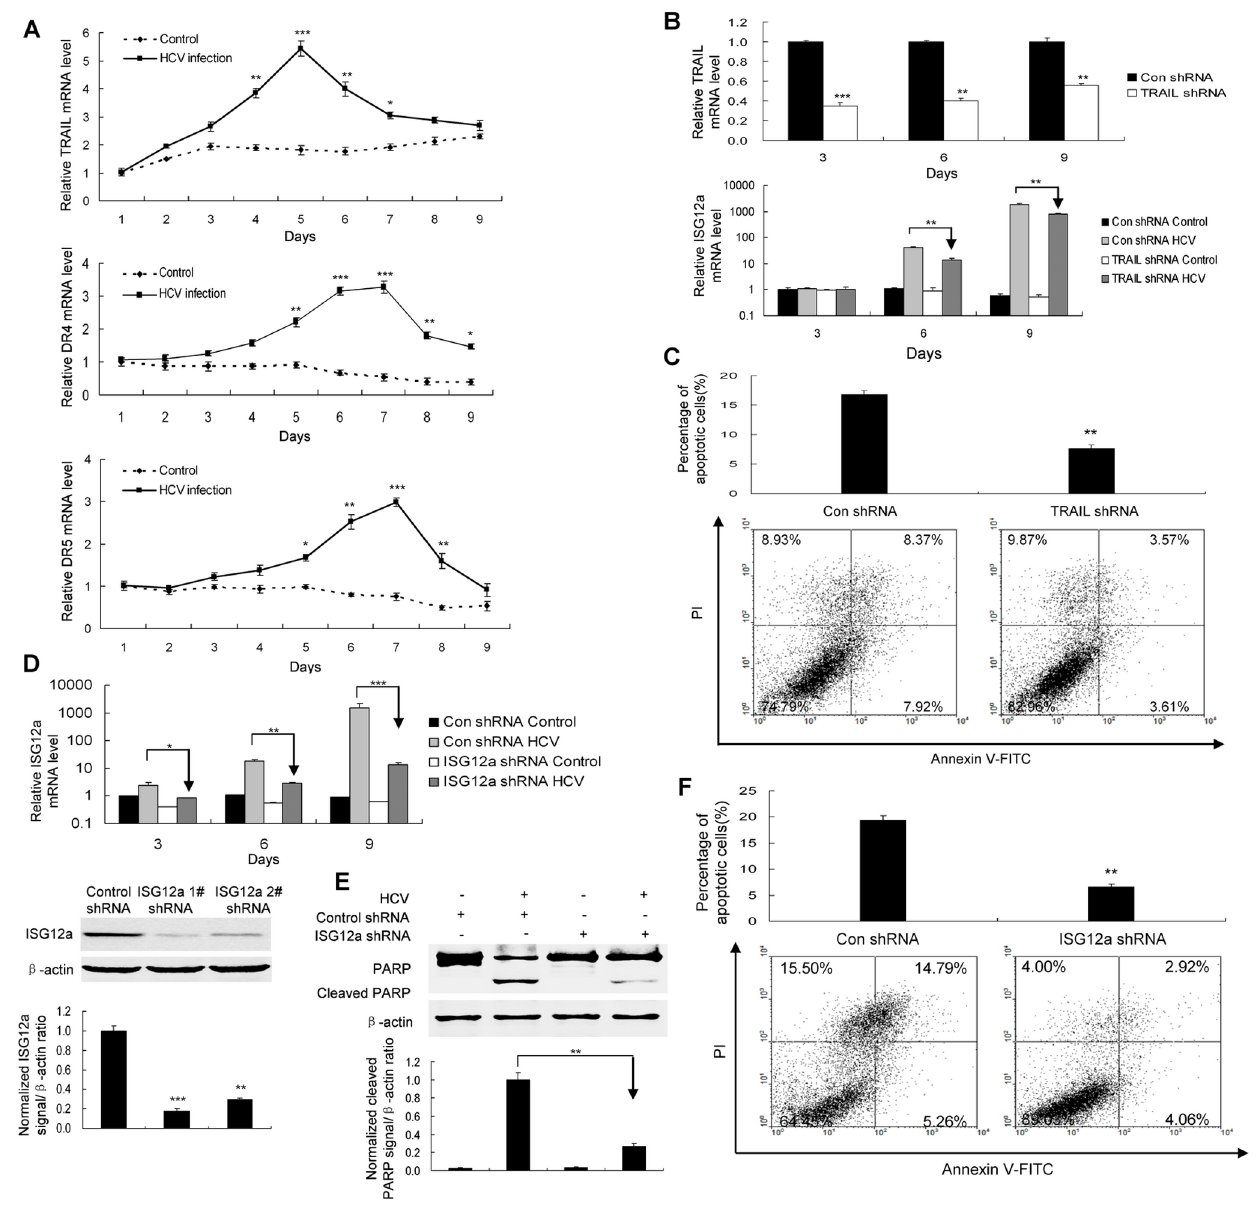
Figure 5. Apoptosis induction by HCV infection in HLCZ01 cells involves ISG12a which relies on TRAIL-mediated pathway. ( A ) HCV infection induced TRAIL and its receptors DR4 and DR5. HLCZ01 cell were infected by HCV at MOI of 0.1 for different time periods. TRAIL, DR4 and DR5 mRNA was examined by real-time PCR and normalized with GAPDH. ( B/C ) Silencing of TRAIL inhibited the induction of ISG12a and blocked apoptosis of viral-infected cells. TRAIL shRNA was delivered into HLCZ01 cells, followed by HCV infection. (B) TRAIL and ISG12a mRNA was detected by real-time PCR and normalized with GAPDH. (C) Cells were collected for flow cytometry analysis. ( D ) Confirmation of ISG12a knockdown with ISG12a-specific shRNA in HLCZ01 cells. The plasmid pSilencer-ISG12a shRNA was delivered into HLCZ01 cells. ISG12a mRNA and protein was detected by real-time PCR and western blot receptively. ( E/F ) ISG12a knockdown prevented HCV-infected HLCZ01 cells from apoptosis. The plasmid pSilencer- ISG12a shRNA was delivered into HLCZ01 cells. The cells were infected with HCV for 9 days. PARP cleavage was examined by western blot (E). The cells were examined by flow cytometry (F). If not stated otherwise bar graphs represent means of three independent experiments. doi:10.1371/journal.pone.0094501.g005 protein level (Figure S3G). The expression of miR-942 expression was downregulated in viral-infected cells at earlier phase and return to normal level at late phase. The expression of ISG12a increased too fast to be inhibited by miR-942 at later phase. All the data supported that the ISG12a is a direct targeted gene of miR- 942.